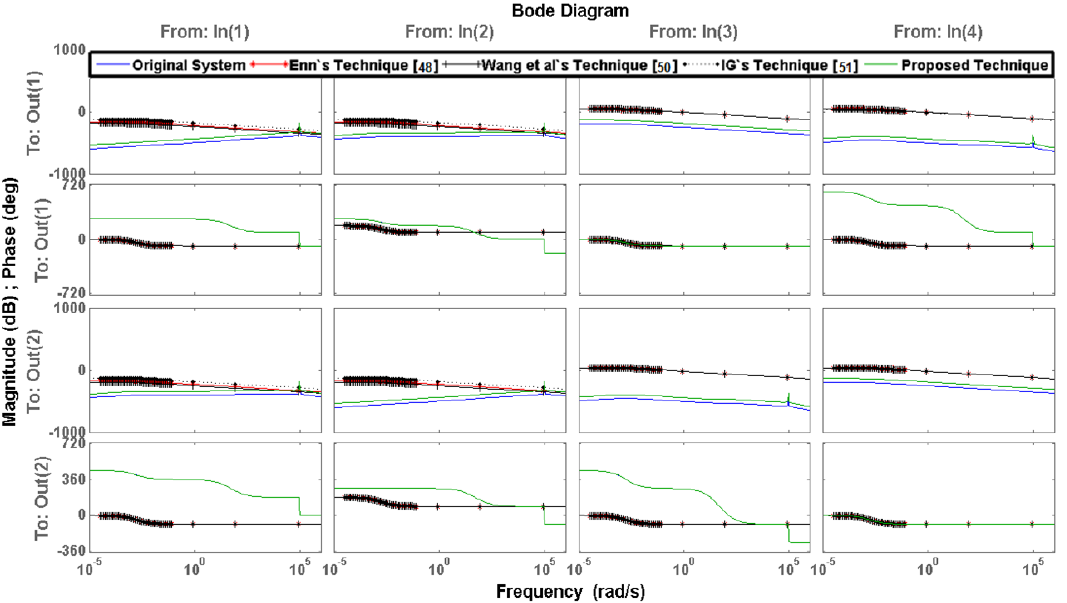
Figure 7. Frequency response Bode plot (magnitude and phase) in the given frequency weights of 1st order for Example 1.